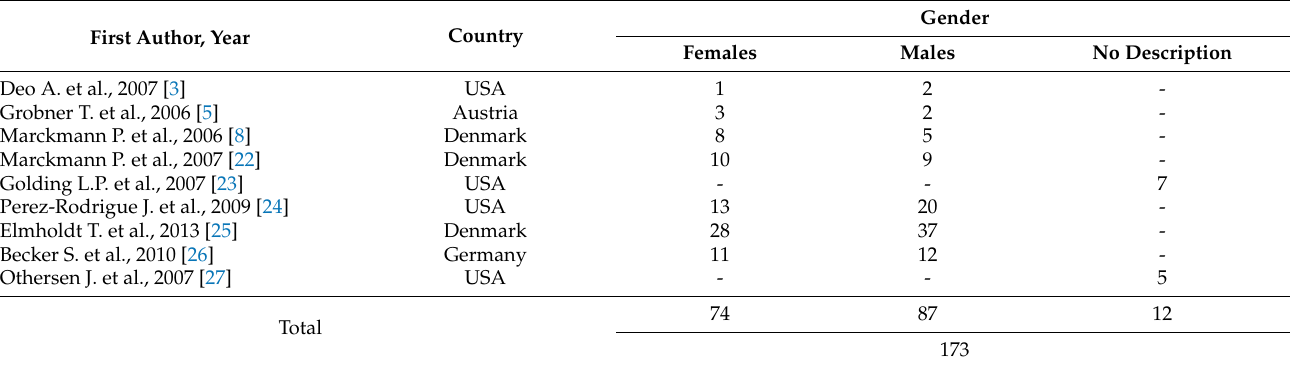
Table 6. Demographic and social